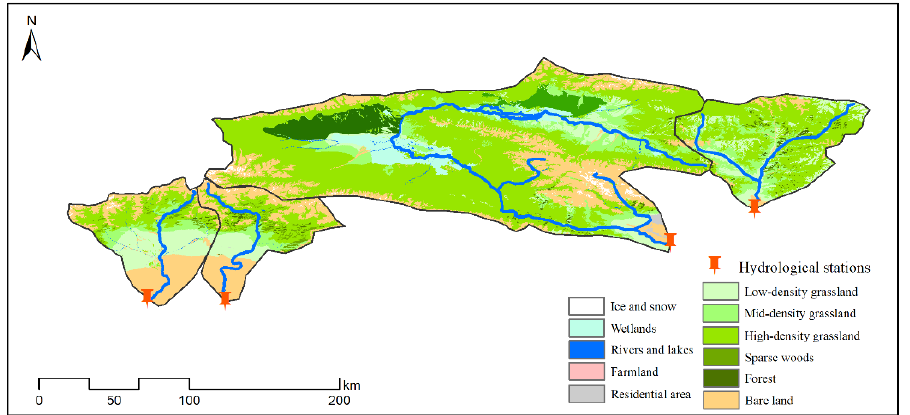
Figure A1. Land cover classification map for the four basins. This map has a spatial resolution of 30 m and was derived from Landsat images during 2010. The dataset is by provided by Data Center for Resources and Environmental Sciences, Chinese Academy of Sciences (RESDC)